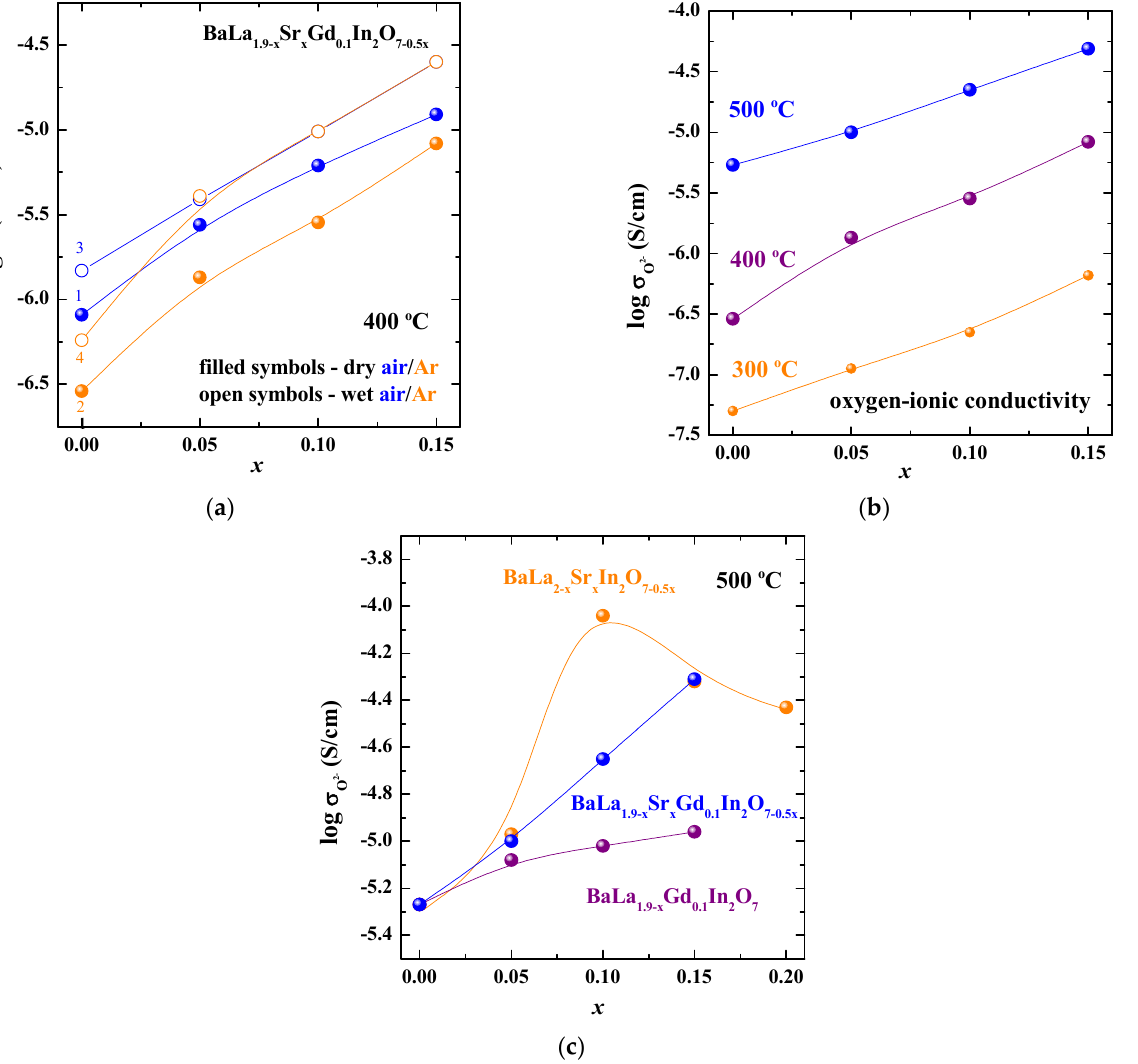
Figure 5. The concentration dependencies of conductivity for the solid solution BaLa 1.9− x Sr x Gd 0.1 In 2 O 7−0.5 x in dry air (1), dry Ar (2), wet air (3), wet Ar (4) ( a ); the concentration dependencies of oxygen-ionic conductivity for the solid solution BaLa 1.9− x Sr x Gd 0.1 In 2 O 7−0.5 x at 300 °C, 400 °C, 500 °C ( b ); the concentration dependencies of oxygen-ionic conductivity for the solid solutions BaLa 1.9− x Sr x Gd 0.1 In 2 O 7−0.5 x , BaLa 2− x Sr x In 2 O 7−0.5 x [38] and BaLa 2− x Gd x In 2 O 7 [39] at 500 °C ( c ).